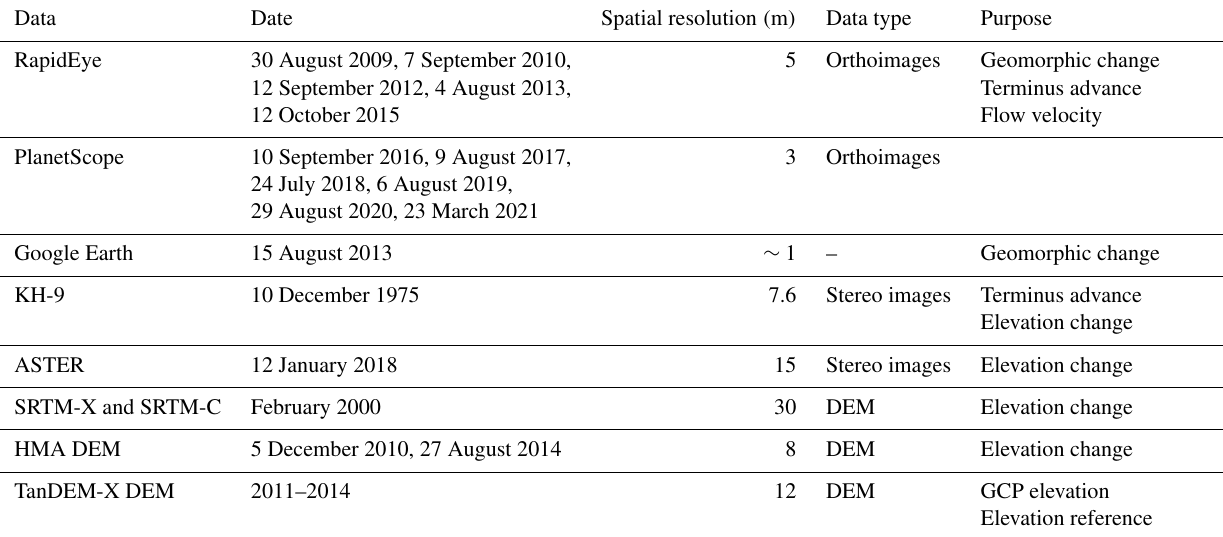
Table 1. Satellite imagery and DEMs used in this